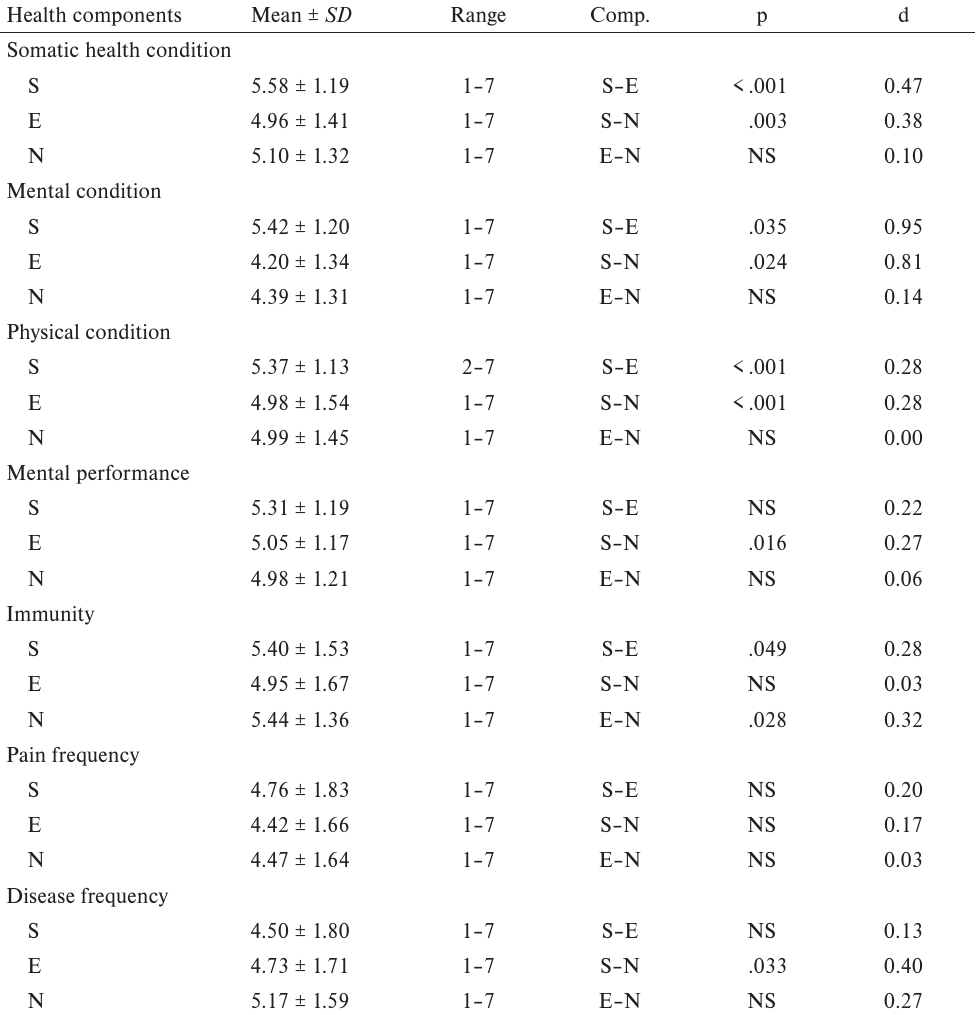
Table 3 Comparison of life satisfaction in the area of subjective assessment of health in current university students with respect to study